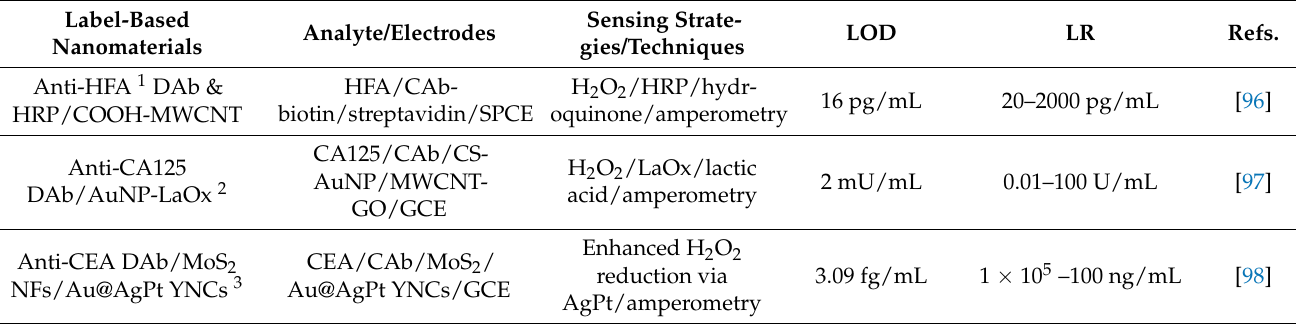
Table 3. Deposition methods by labeled nanomaterials for immunosensor